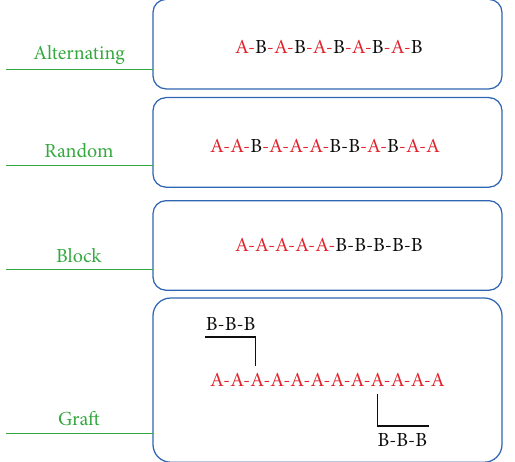
Figure15:Theschematicofsomecopolymermodeslikealternating, random, block, and graft